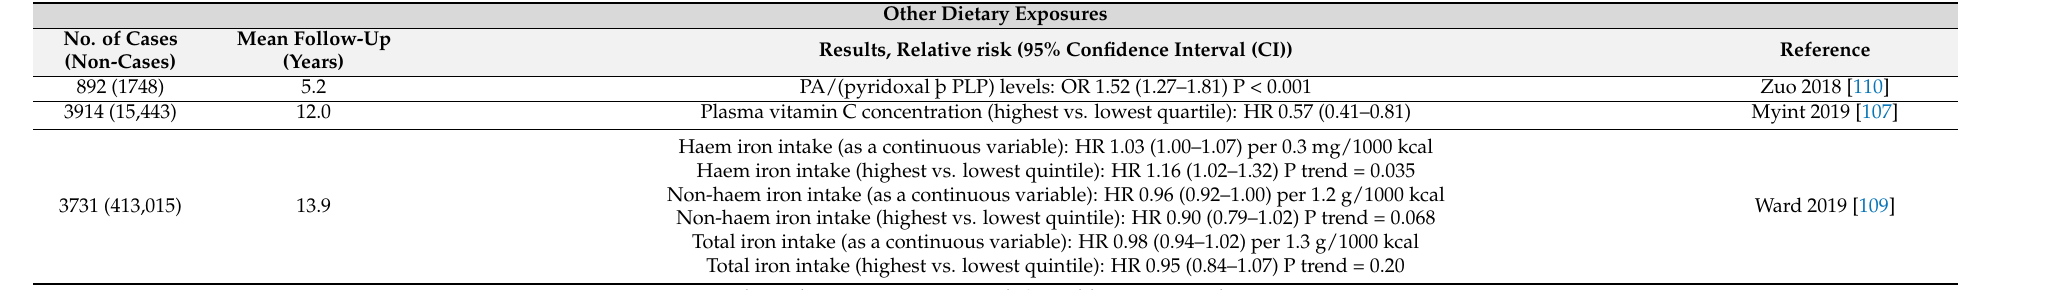
Table 3. Cont. Other Dietary Exposures